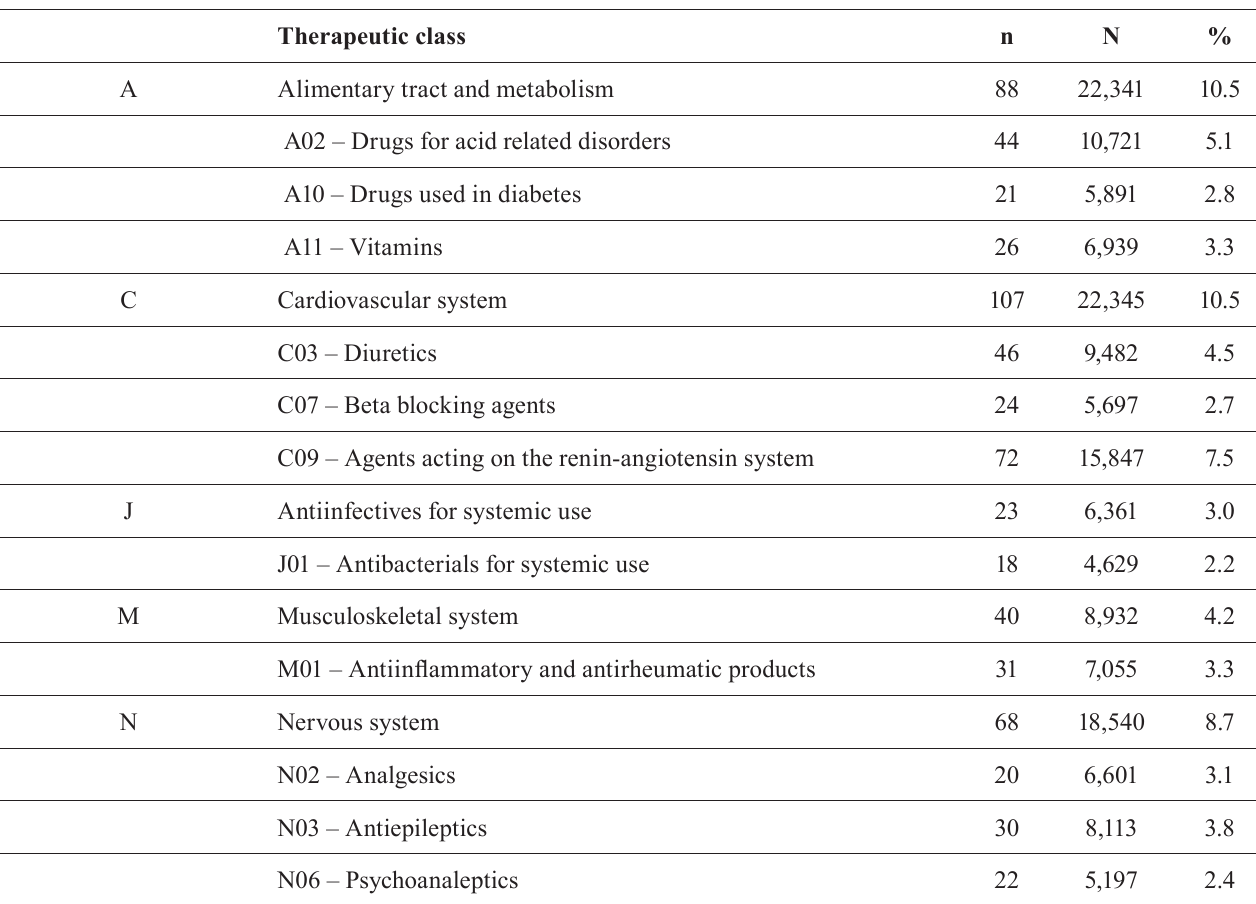
TABLE I - P revalence of medicine used according to the Anatomical Therapeutic Chemical (ATC) Classification System by the population aged 18 to 59 years from Rio Branco, Acre, Brazil, 2014 Therapeutic class